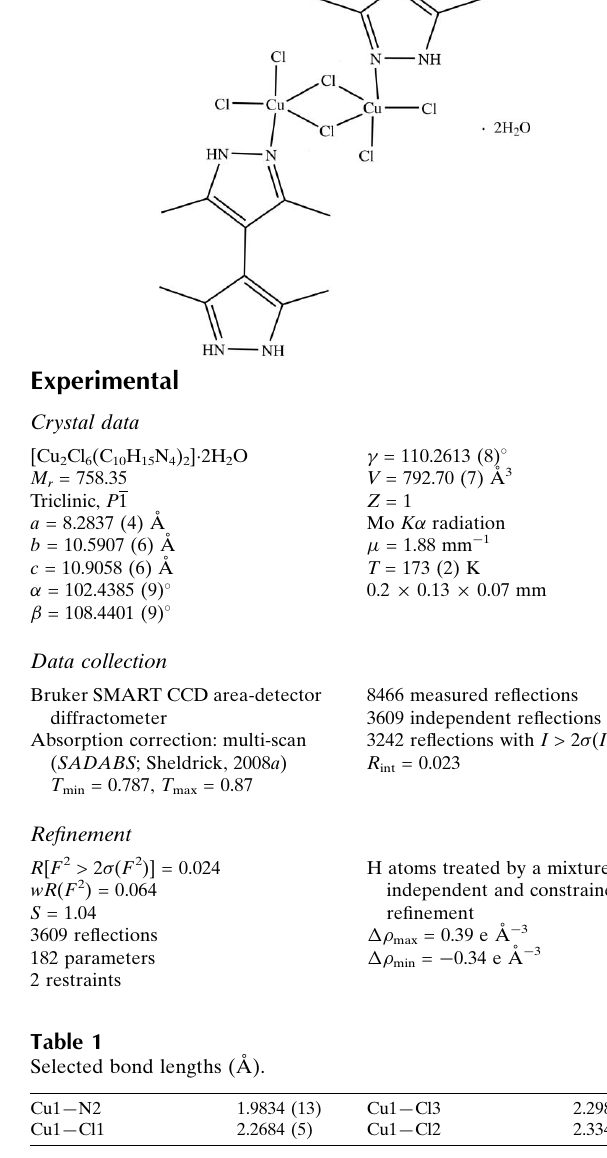
Key indicators: single-crystal X-ray study; T = 173 K; mean (cid:1) (C–C) = 0.003 A ˚ ; R factor = 0.024; wR factor = 0.064; data-to-parameter ratio = 19.8.